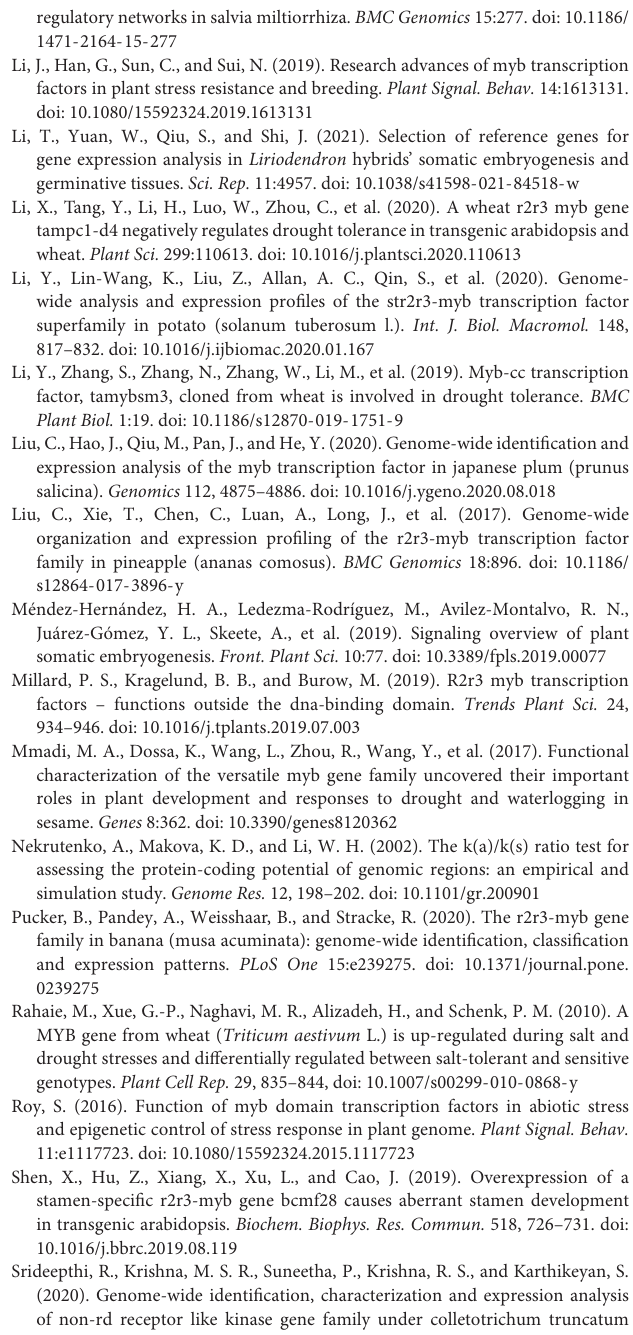
Supplementary Table 7 | Gene position of LchiMYBs . Supplementary Table 8 | Synteny gene pairs of LchiMYBs . Supplementary Table 9 | Selective pressure analysis of LchiMYB -duplicated gene pairs. Supplementary Table 10 | Protein sequences of 190 LchiMYBs . Supplementary Table 11 | Protein sequences of Lchi and ATG R2R3-MYBs.